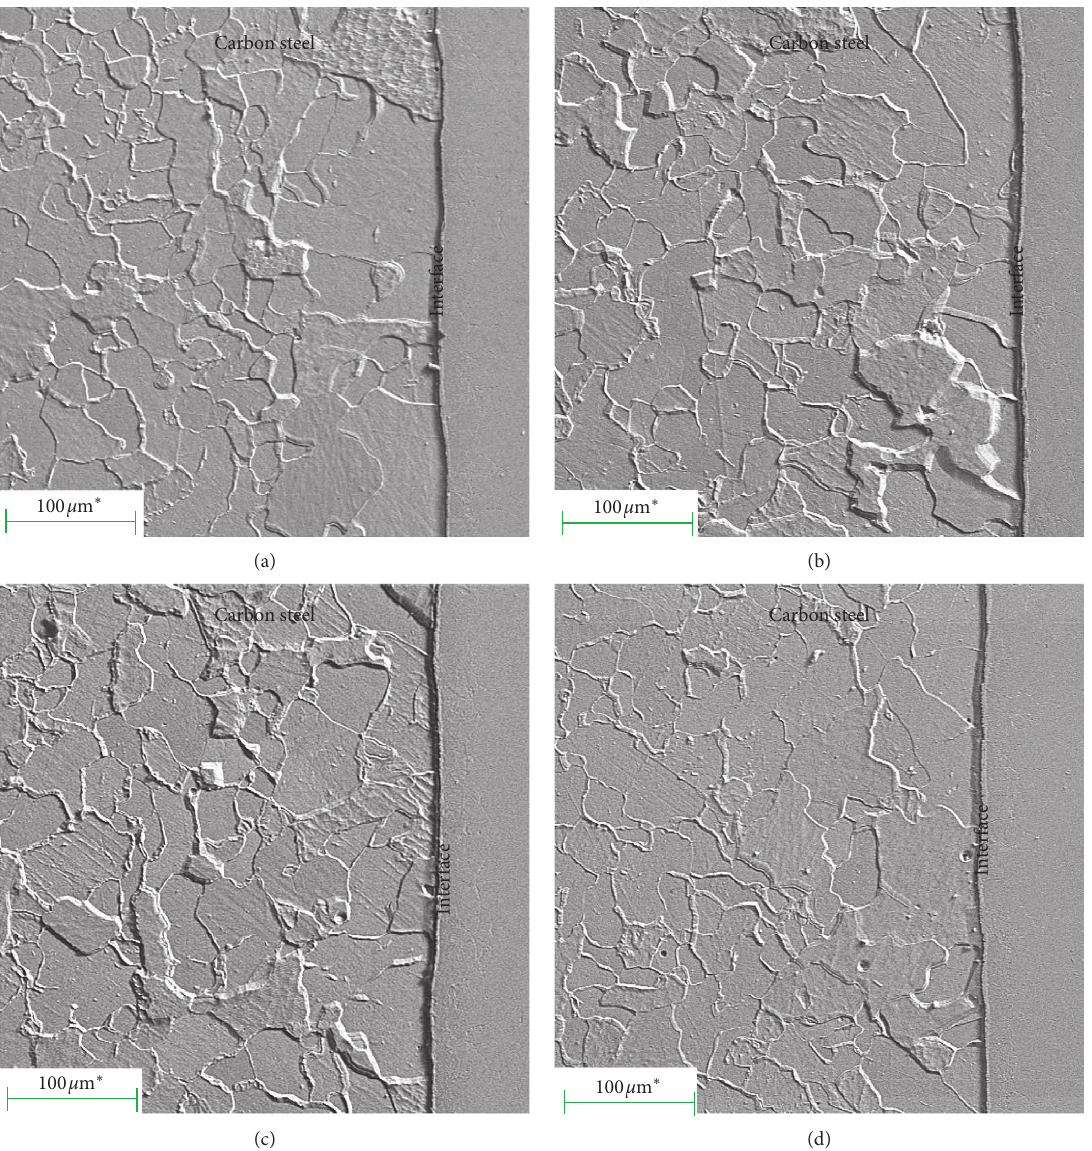
Figure 8: The microstructure in the thickness direction of carbon steel (substrate) in the bimetal plate at 700 ° C with different annealing times: (a) 2h, (b) 4h, (c) 6h, and (d) 8